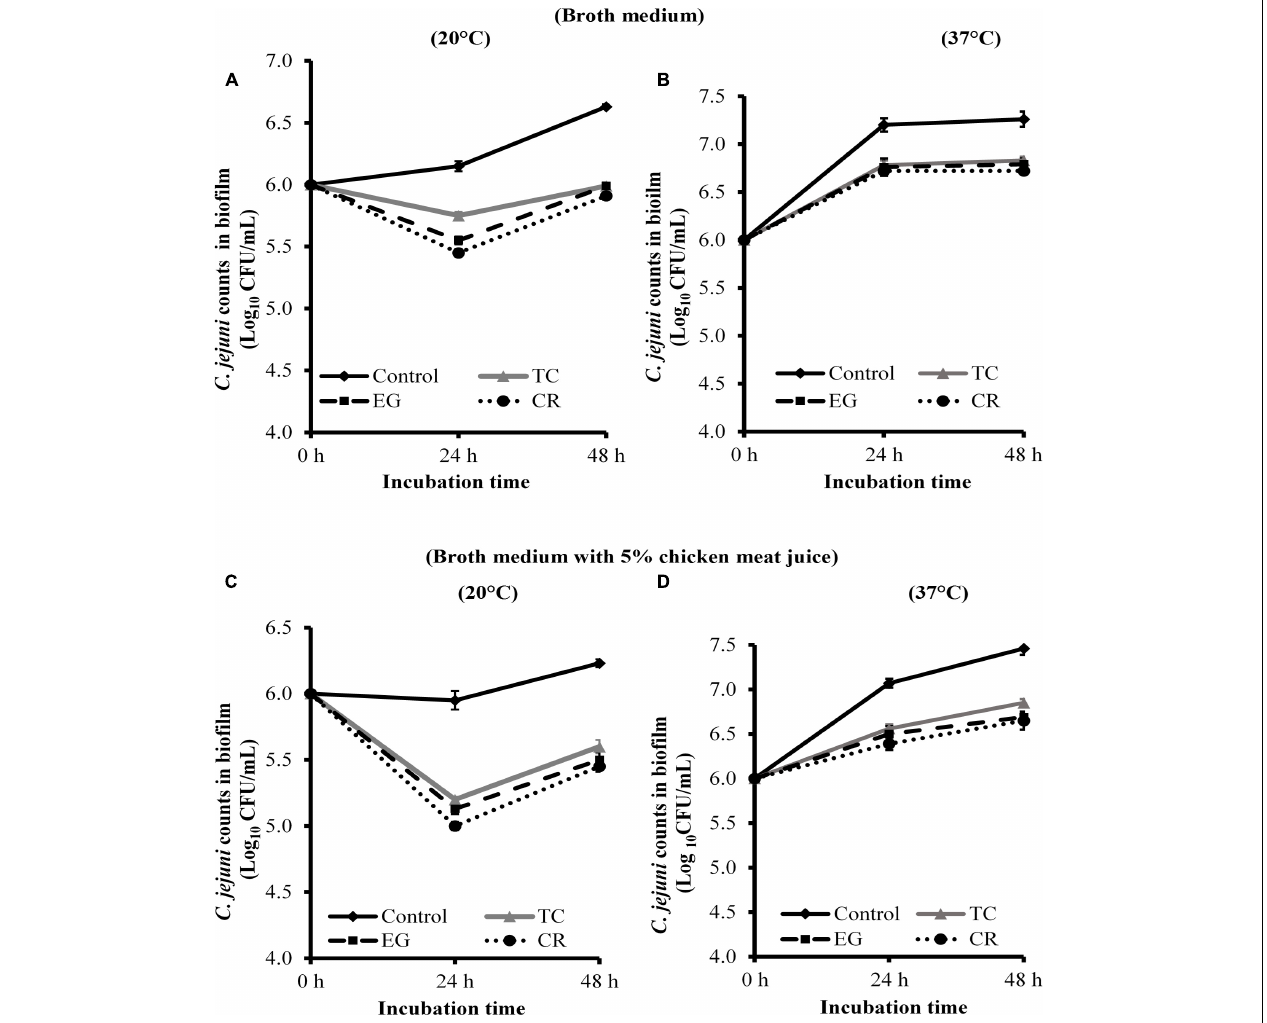
FIGURE 3 | Effect of SICs of trans -cinnamaldehyde (TC), eugenol (EG), and carvacrol (CR) on Campylobacter jejuni NCTC 11168 biofilm formation on stainless-steel coupons in the broth medium (A,B) and in the presence of 5% chicken meat juice (C,D) . Error bars represent SEM ( n = 6). C. jejuni ( ∼ 6.0 Log CFU/mL) in the presence of TC (0.75 mM), EG (0.61 mM) or CR (0.13 mM) was incubated to form biofilm on steel coupons at 20 ◦ C (A,C) or 37 ◦ C (B,D) . The number of C. jejuni in the biofilm was enumerated at 24 or 48 h. All treatments were significantly different from control at both 24 and 48 h ( P <